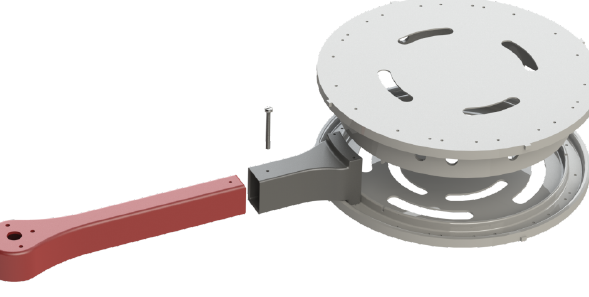
Figure 7. Exploded view of an arm assembled with the core.